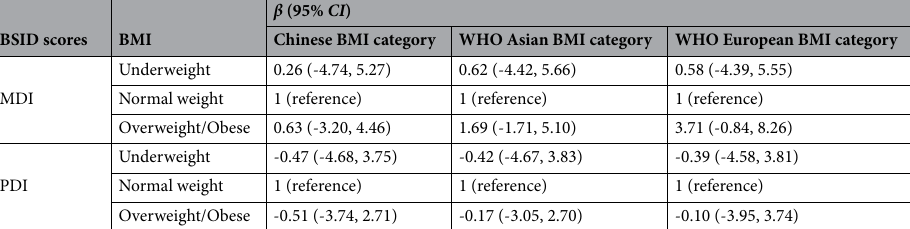
Table 4. Association ( β coefficient with 95% confidence interval) of maternal BMI according to the Chinese, WHO Asian or WHO European BMI classifications with the Mental Development Index (MDI) and the Psychomotor Development Index (PDI). Adjusted for maternal age, gestational weight gain (continuous), Han ethnicity, marital status, history of miscarriage or abortion, smoking or drinking during pregnancy, maternal educational level, participant and partner’s income, gestational age at delivery, new born sex, Apgar score at 1 min, Apgar score at 5 min and child age at neurocognitive follow-up (months). BMI body mass index, CI confidence intervals, MDI Mental Development Index, PDI Psychomotor Development